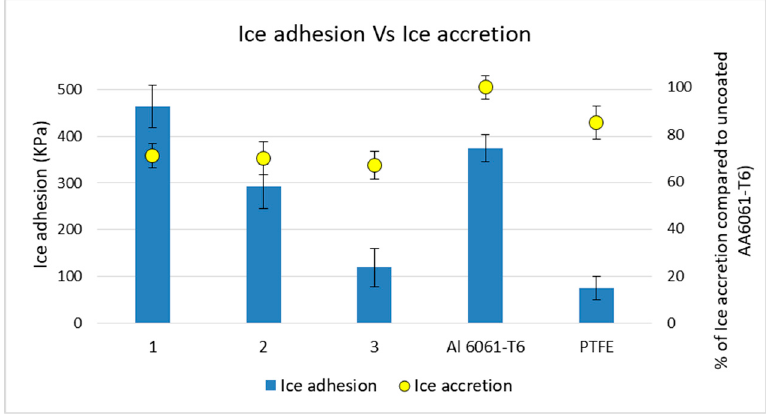
Figure 12. Ice adhesion versus ice accretion of the coatings of study.